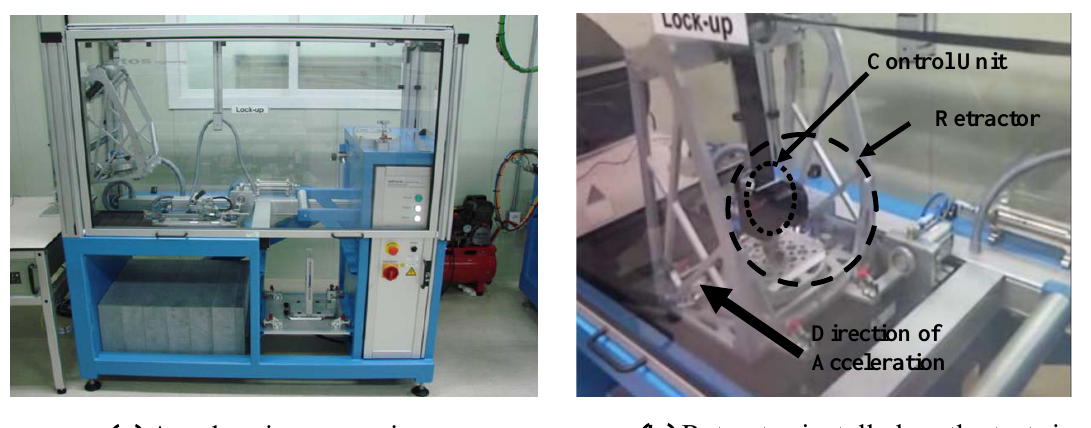
Figure 12. Equipment for acceleration experiment.